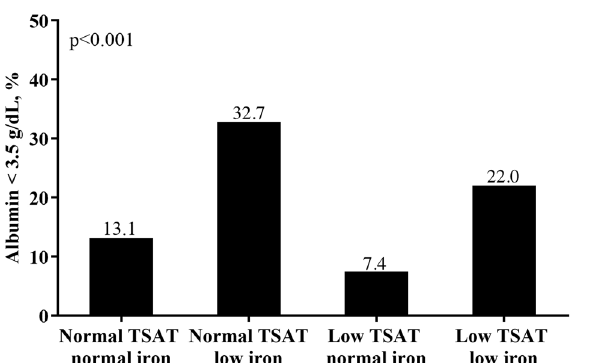
Figure 3. Malnutrition divided by TSAT and serum